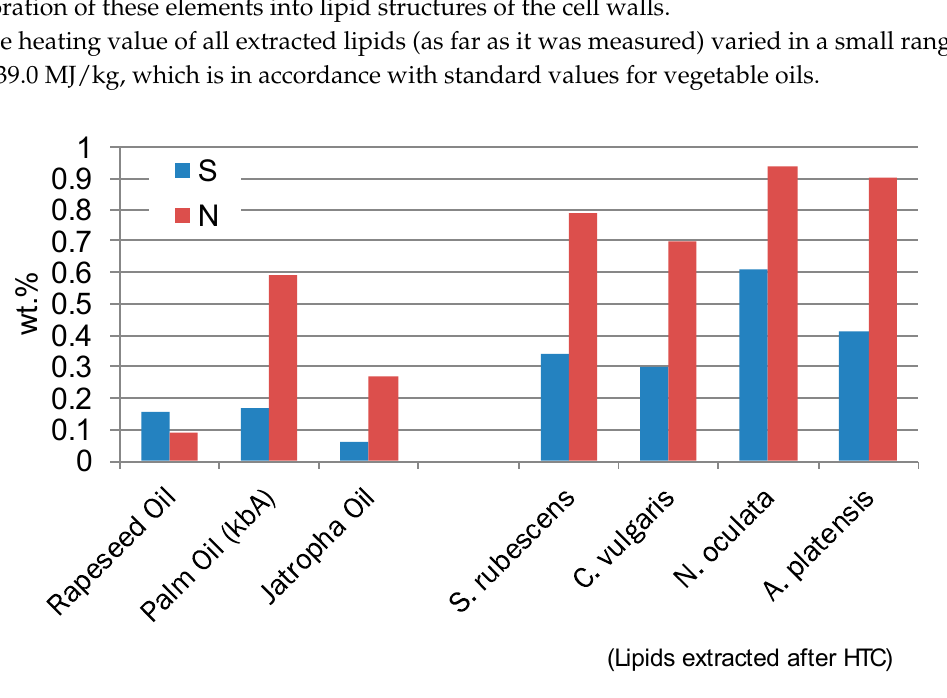
Figure 4. Sulphur and Nitrogen content of extracted lipids after HTC in comparison to vegetable oils (unpublished data).